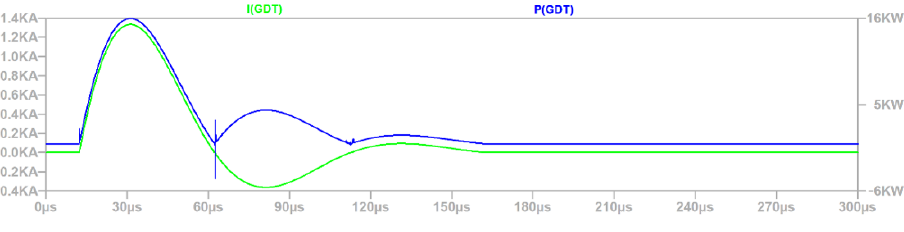
Figure 9. Power and current waveforms of GDT.